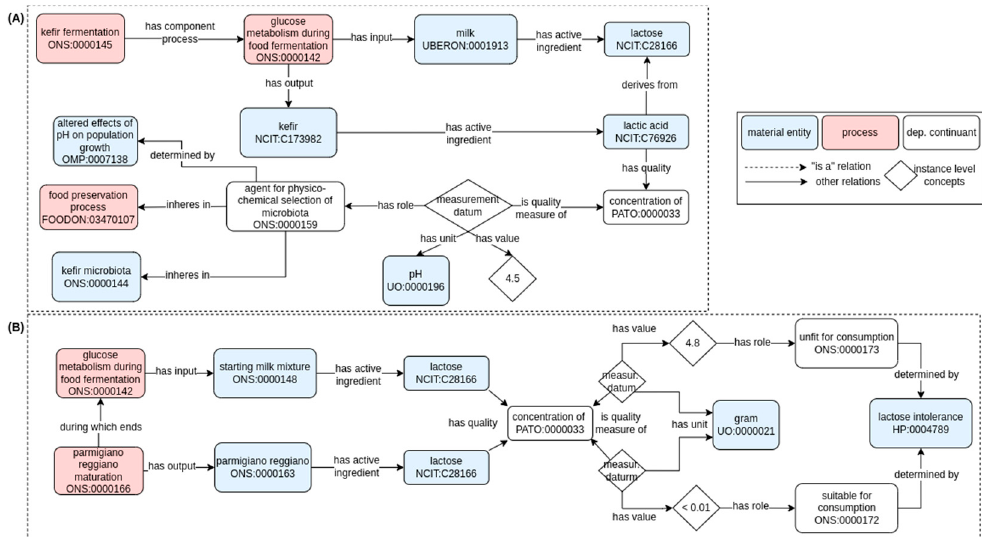
Figure 5. Ontological model depicting some technological (i.e., food preservation) ( A ) and nutritional (i.e., being suitable for consumption to lactose-intolerant subjects) ( B ) services provided by the microbiota in dairy fermented foods. Solid arrows represent semantic relations in RO (annotated with their label), while dashed arrows represent hierarchical relationships (i.e., “is a” relation). Pink and blue rectangles refer to process or material entity, respectively. The label and the term ID (formatted as an ontology prefix followed by a number) are reported for each class. Classes are generally conceptualized to the universal level (i.e., the definition and concepts apply to any possible class instance). When suitable, instance-level concepts (indicated with white rhombus) indicate a particular instance of the universal concept.